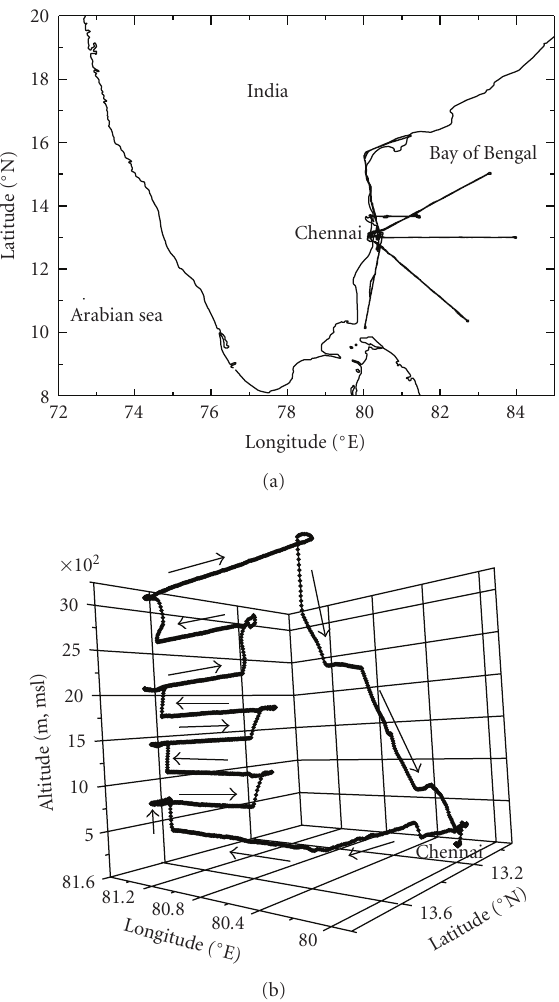
Figure 1: The flight paths of the aircraft from Chennai (a). The red line corresponds to the ground trace of the aircraft flight track during the multilevel sortie and the blue line corresponds to the ground trace of the sorties used for examining latitudinal gradient at two altitudes. (b) The track in which the high resolution vertical profiling was done at 8